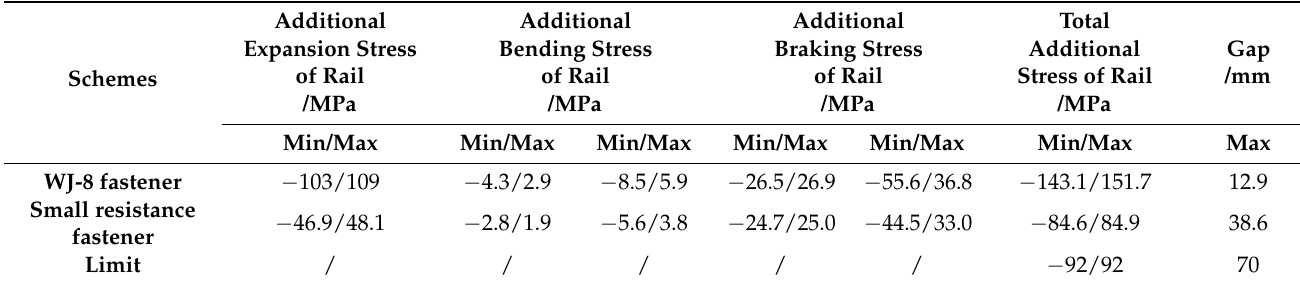
Table 5. Comparison of various additional stresses and strength checks with different fasteners.